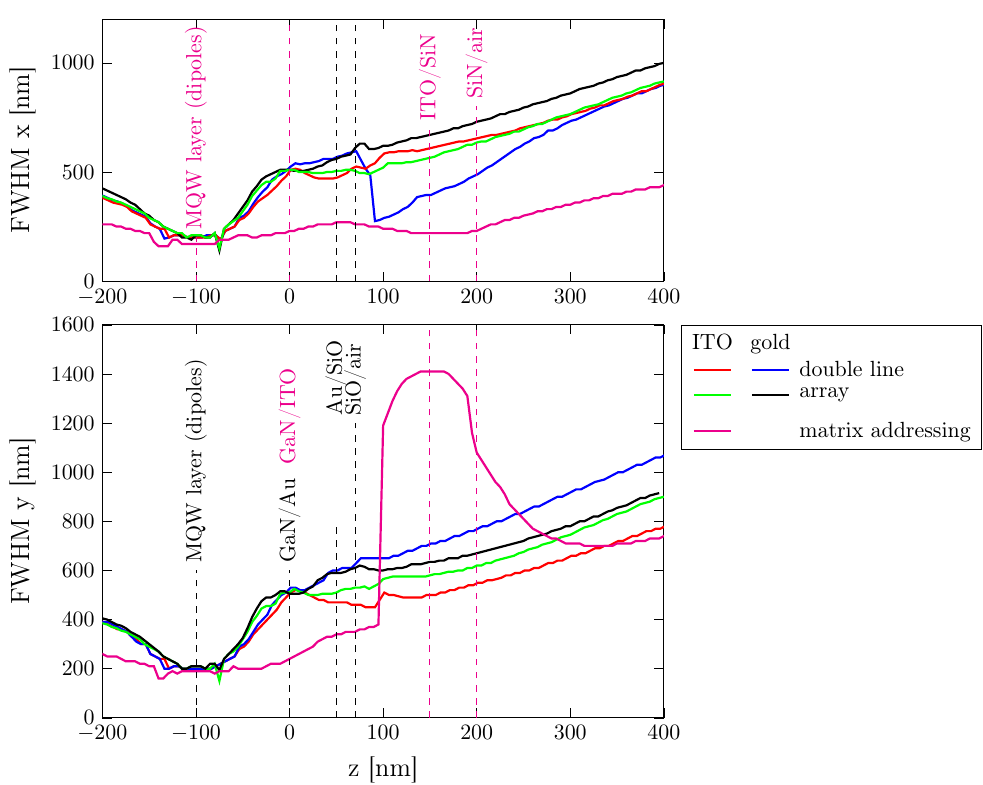
Figure 4. FWHM in x ( top ) and y ( bottom ) direction as a function of the position along z axis. We compare the LED arrays in direct addressing technology (red and blue for double line, green and black for the array) with the array using matrix addressing approach (magenta). The dashed vertical lines indicate the location of the material interfaces inside the LEDs (black for direct addressing scheme and magenta for matrix addressing scheme). The large increase around the ITO/SiN interface in the matrix addressing device is due to guiding along the ITO top contact lines, oriented along y . FWHM along x is reduced due to the etch pattern. In the case of the direct addressing double line device with gold contacts (blue), the FWHM along x apparently decreases sharply in correspondence of the passivation surface, which is due to the blocking effect of the metallization, as seen also in Figures 2b and 5b.